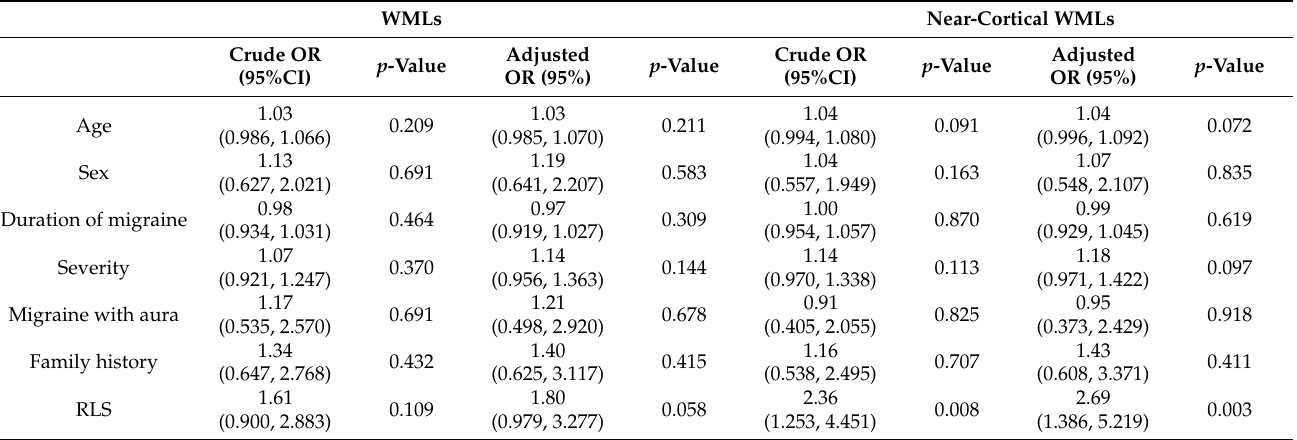
Table 5. Multivariate logistic regression analysis of white matter lesions and near-cortical white matter lesions. WMLs Near-Cortical